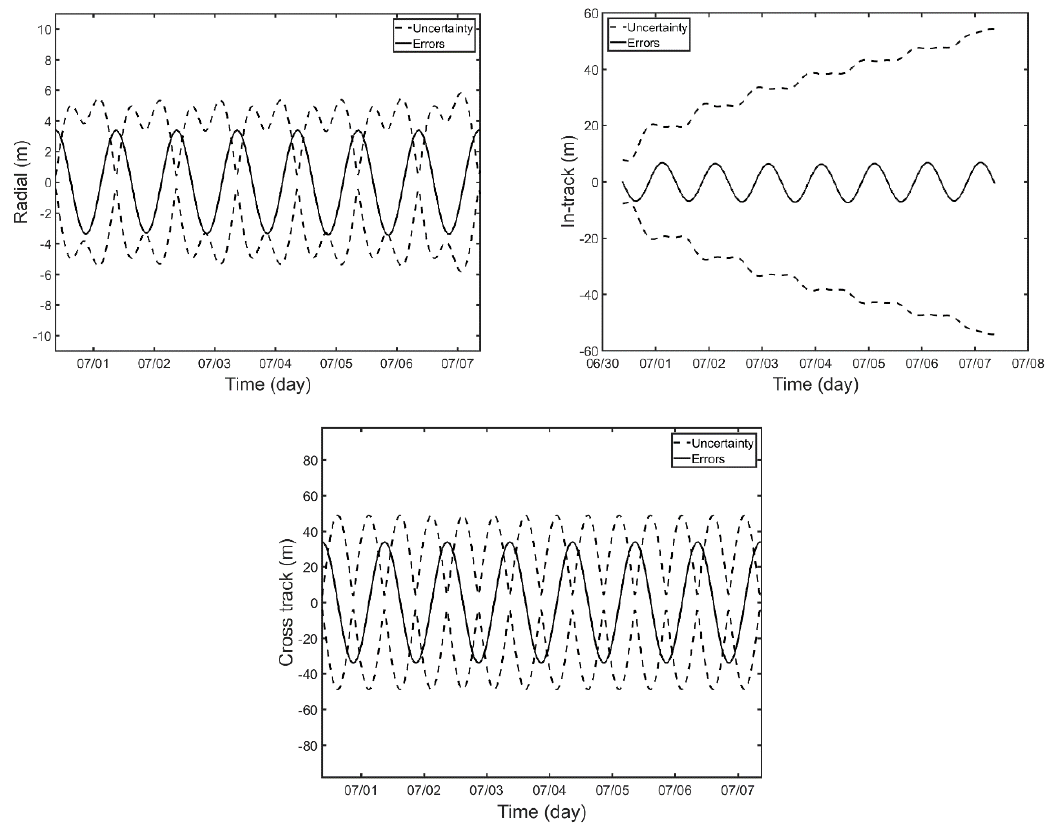
Figure 10. Estimated orbit uncertainty and orbital errors for Scenario 2 in radial ( upper left ), in-track ( upper right ), and cross-track ( lower ) directions.